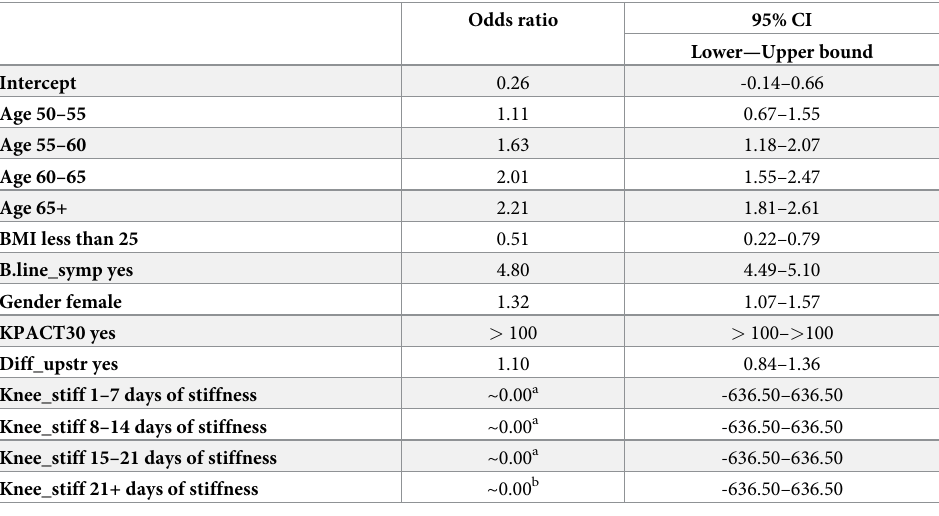
Table 3. Coefficients of logistic